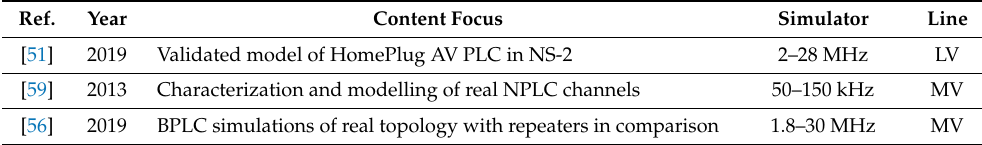
Table 4. Papers dealing with comparison of simulations and measurements.